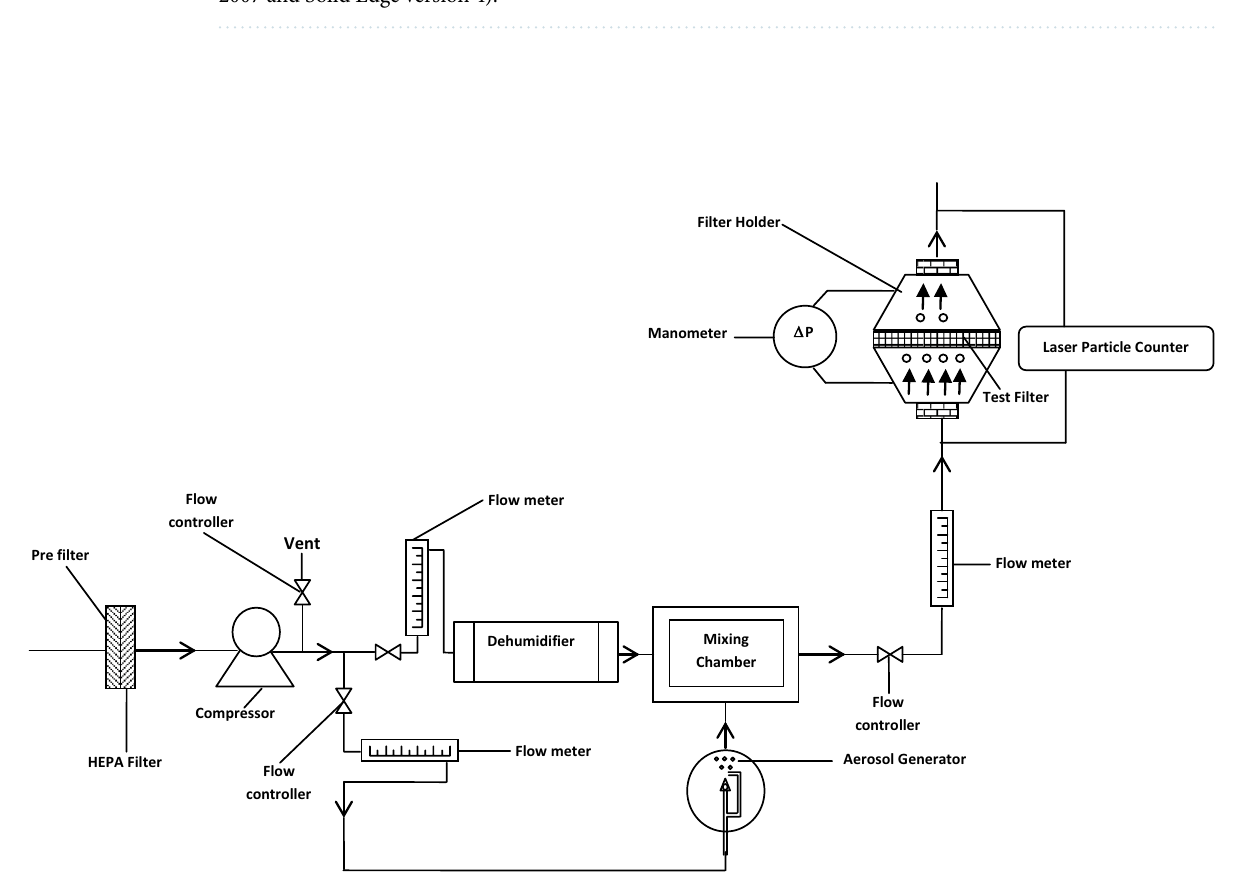
Figure 1. Schematic representation of the respiratory mask showing the various layers and importance of differ layer of mask with emphasis of PP-MB-NW against most penetrating particle size (drawn using Microsoft Office 2007 and Solid Edge version 4).